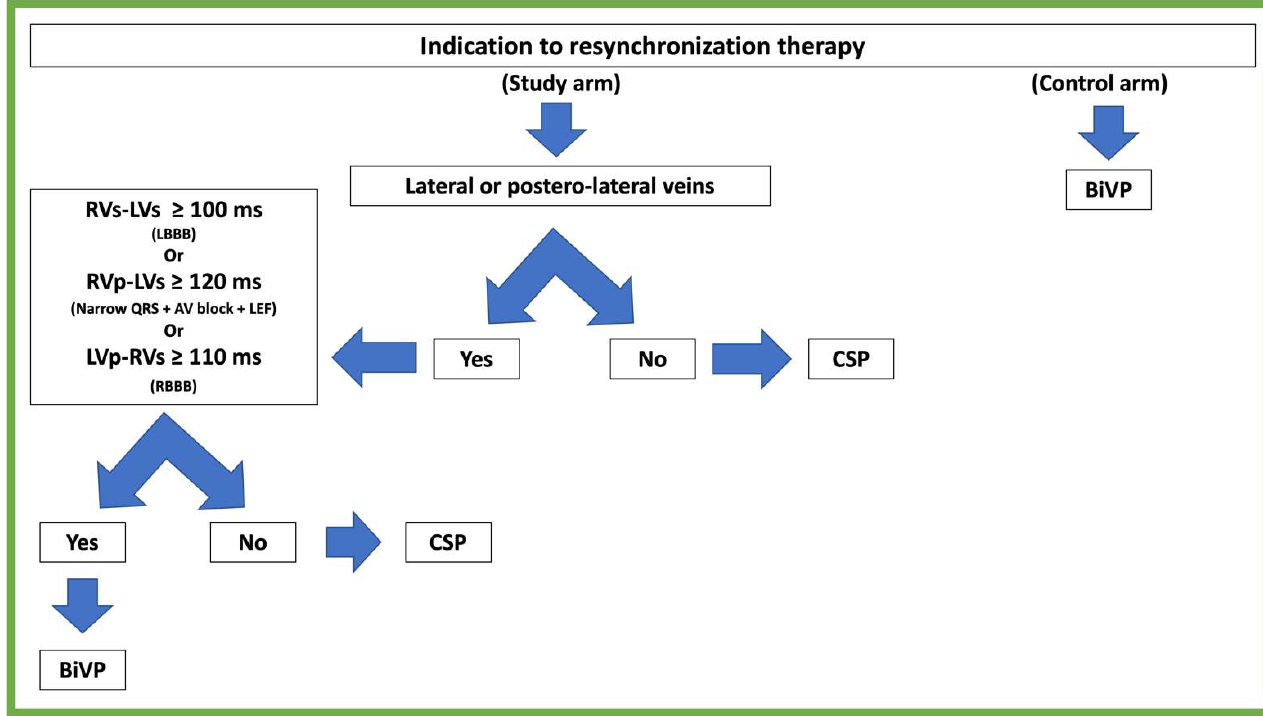
Figure 1. Detailed treatment algorithm. RVs-LVs: interventricular interval between right-ventricle sensed electrogram and left-ventricle sensed electrogram. RVp-LVs: interventricular interval between right-ventricle paced electrogram and left-ventricle sensed electrogram; LVp-RVs: interventricular interval between left-ventricle paced electrogram and right-ventricle sensed electrogram; LEF: low ejection fraction; AV: atrioventricular.